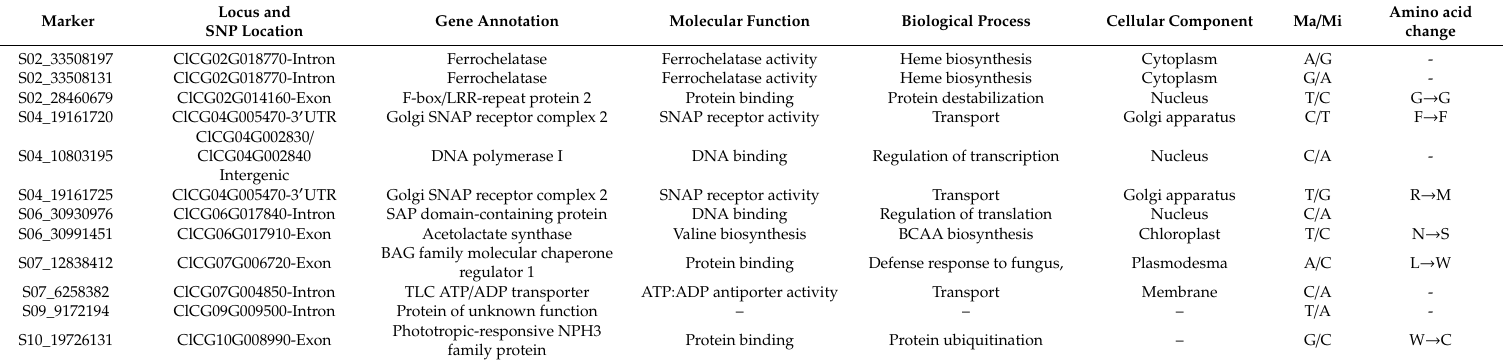
Table 2. Gene ontology classification of the genes associated with significant